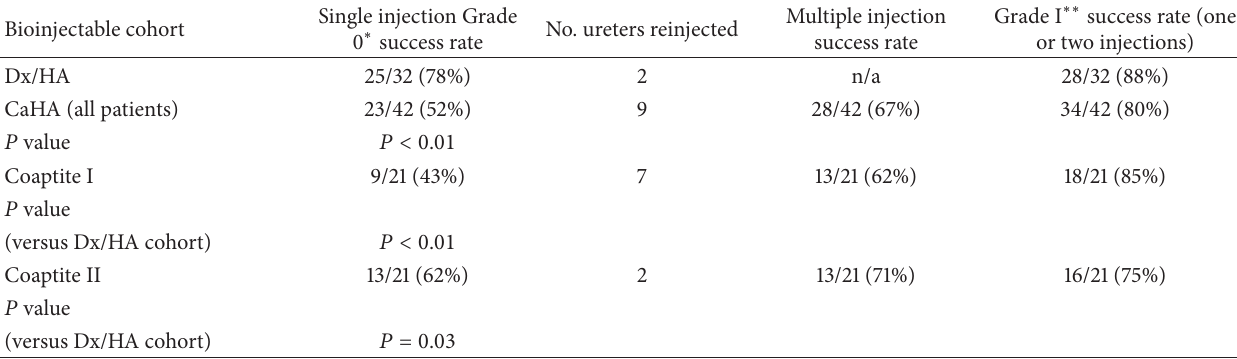
Table 3: Bioinjectable success rates for the endoscopic treatment of